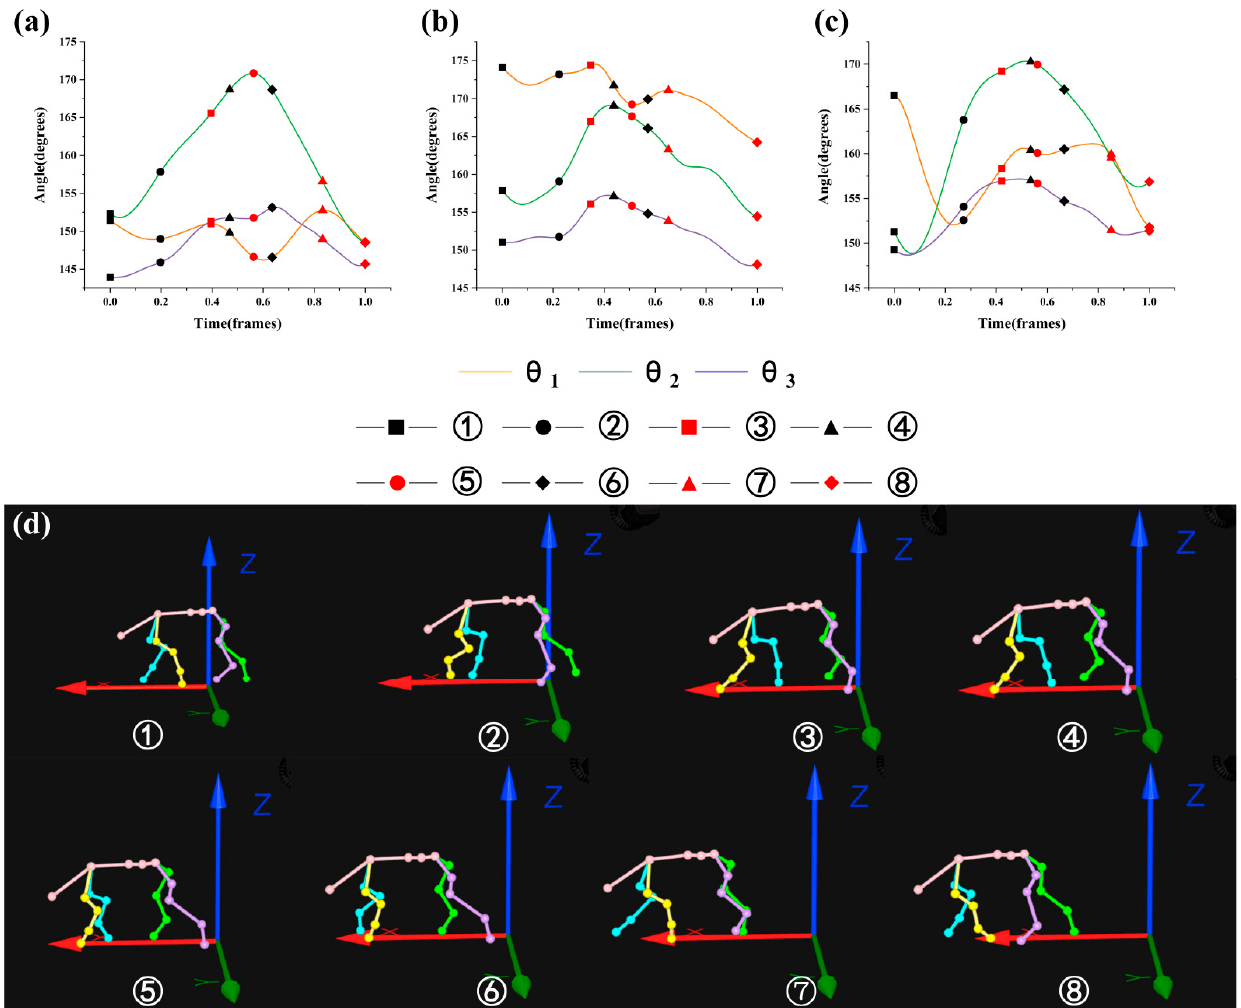
Figure 5. Motion state of goat: ( a – c ) are angle changes of θ 1 , θ 2 , and θ 3 under the slope of 0°; ( d ) eight movements under the slope of 0°.